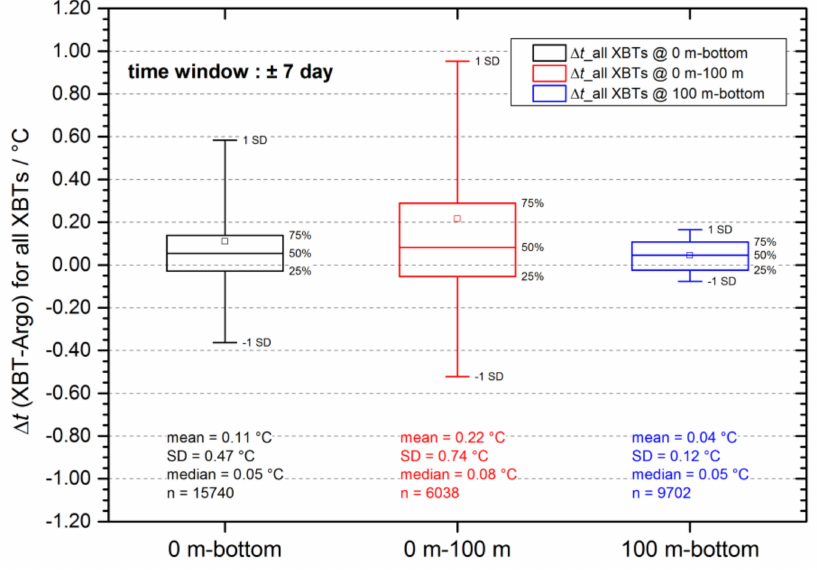
Figure 8. Box plot of temperature di ff erences (XBT-Argo). Mean values are indicated by empty